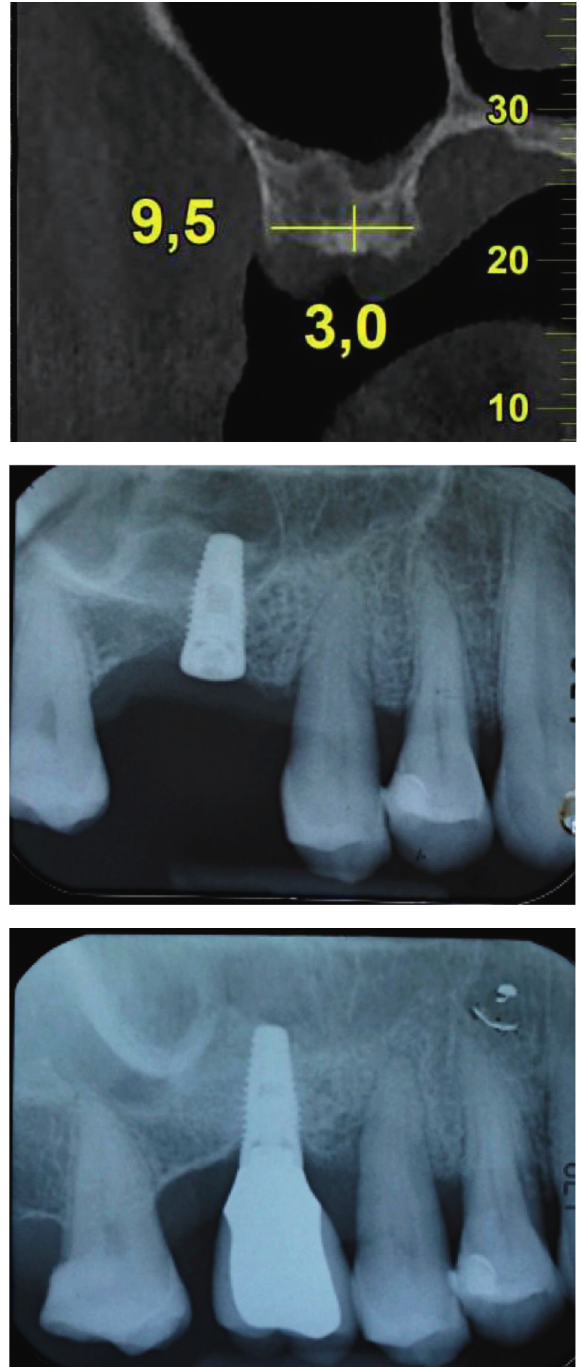
Figure 2: (a) Preoperative CTshowing a crestal width of 9.5 mm and a distance of 3mm from the top of the crest to the lowest point of the maxillary sinus. (b) Periapical radiograph taken immediately after implant insertion. (c) Periapical radiography taken after 9 years of prosthetic loading: note the bone remodeling and the new position of the sinus